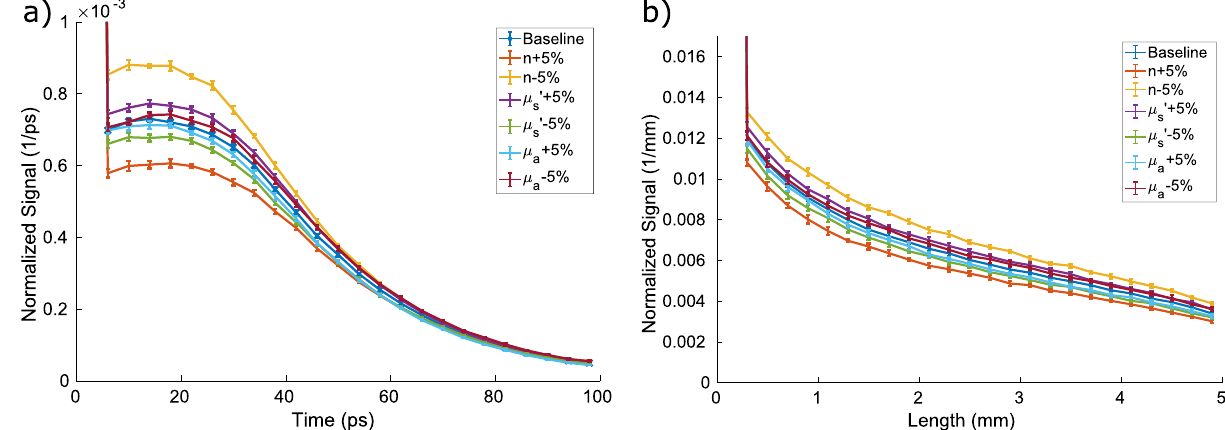
Figure 1. ( a ) Temporal and ( b ) spatial characteristics of a reflected impulse pulse showing the difference for perturbations of the optical parameters. The baseline geometry has n = 1.4 , g = 0.85 , µ s ′ = 1mm − µ a = 0.1mm − 1 , which are realistic values for a slab of tissue. The error bars are the standard deviation of 10 6 independent runs of 10 photons each. The large initial point on each plot is large due to Fresnel